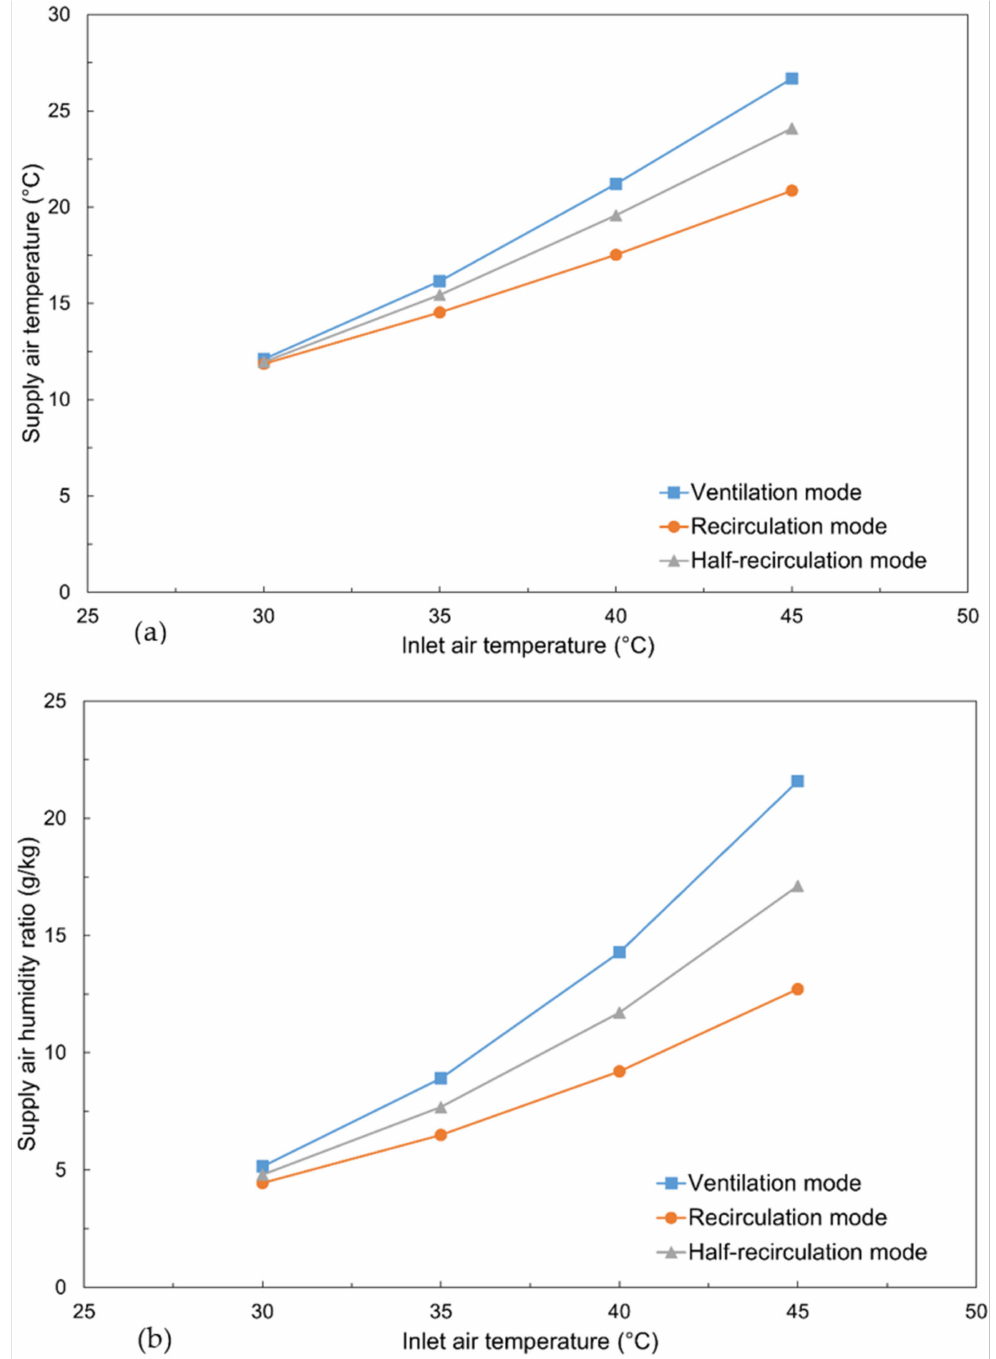
Figure 5. Effect of ambient temperature on supply air ( a ) temperature and ( b )